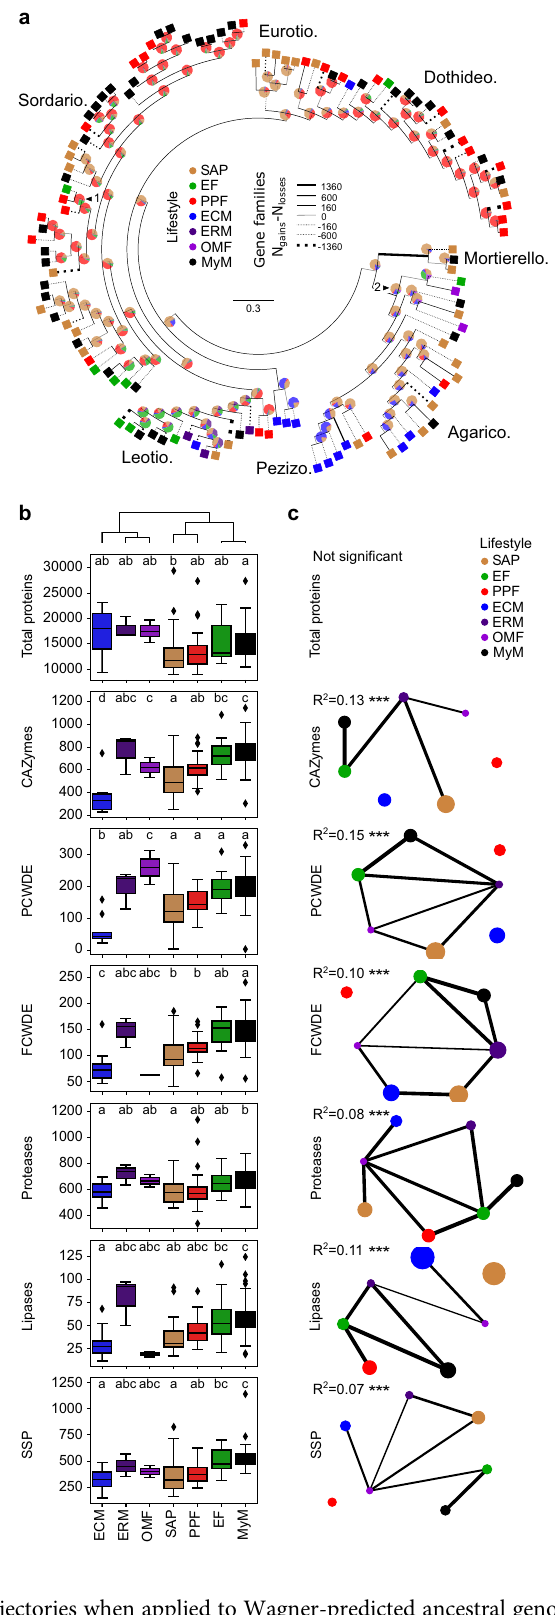
Fig. 2 Ancestral relationships and trait convergence across root- colonizing fungal endophytes. a Lifestyle-annotated whole-genome phylogeny of the 41 selected mycobiota members (MyM, black) and 79 published fungal genomes (SAP saprotrophs, EF endophytic fungi, PPF plant orchid mycorrhizal fungi). Pie charts on ancestor nodes show